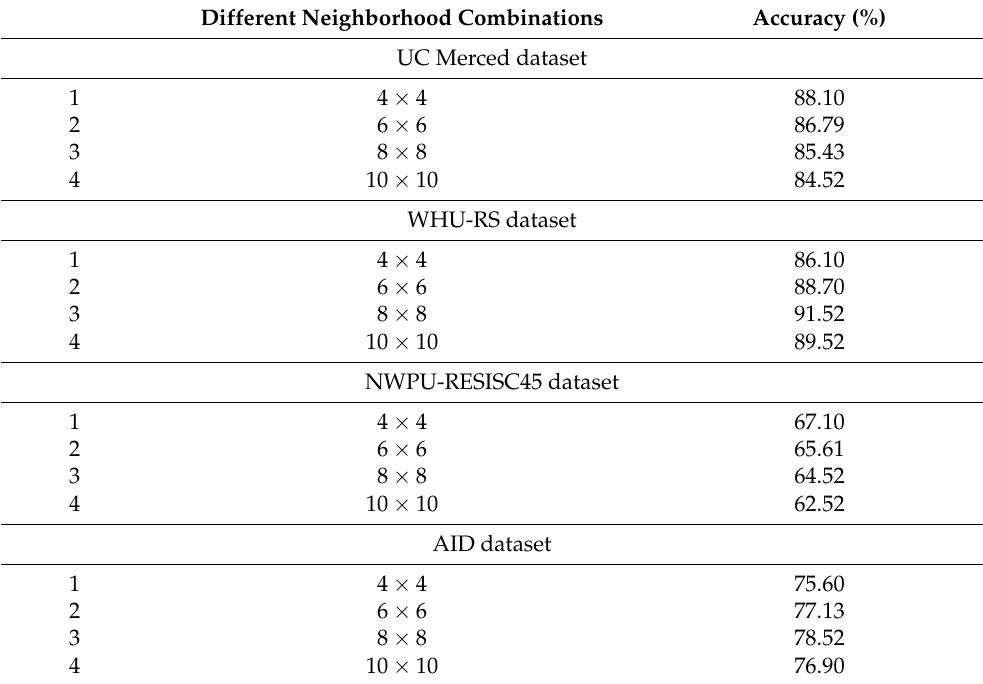
Table 1. Patch-based analysis on each dataset.